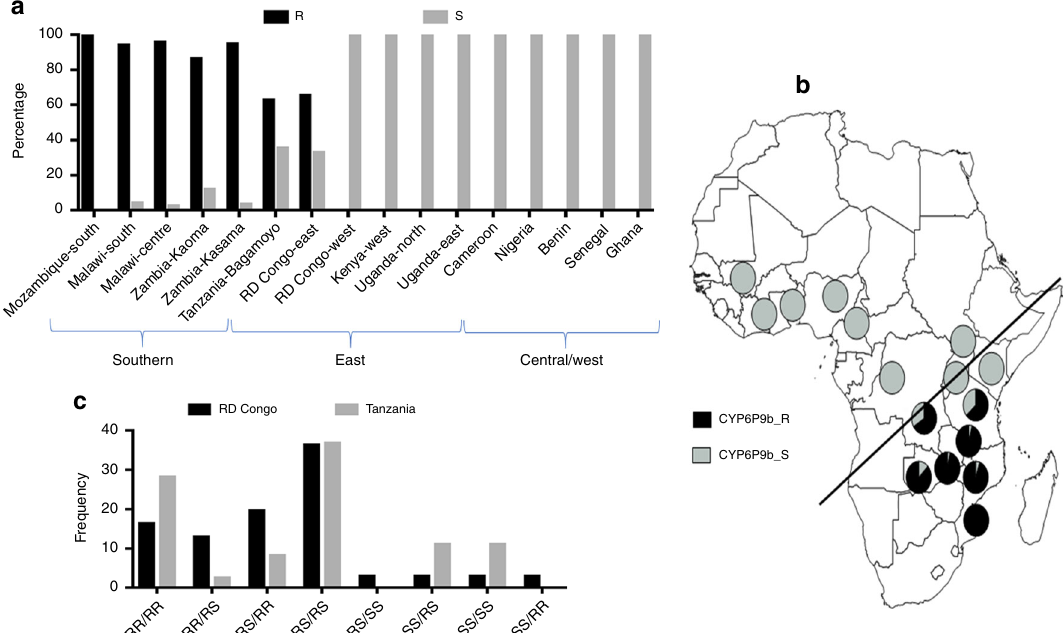
Fig. 4 Geographical distribution of CYP6P9b Africa-wide. a Frequency of the CYP6P9B_R allele across Africa showing that it is highly predominant in southern Africa, moderately present in East Africa but completely absent elsewhere on the continent. b Map of Africa showing the distribution of the CYP6P9b-resistant alleles with a near fi xation in southern Africa. The map was generated using a blank map freely available from https://www. rkkerkenschijndel.nl/map-of-africa-drawing.html and pie-charts representing frequency of both alleles in each location were added on the map. c Comparative distribution of the combined genotypes of CYP6P9a and CYP6P9b in Tanzania and RD Congo supporting an independent segregation of genotypes of both genes in the fi eld. Source data are provided as a Source Data fi